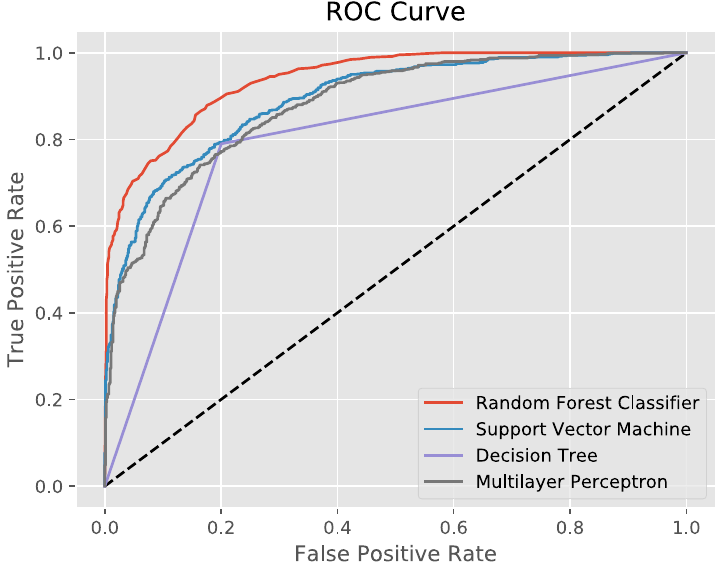
Figure 7. ROC curve for compared classifiers. As the decision tree contains only pure subsets, the class probabilities are either 0 or 1. This leads to a triangled ROC curve.